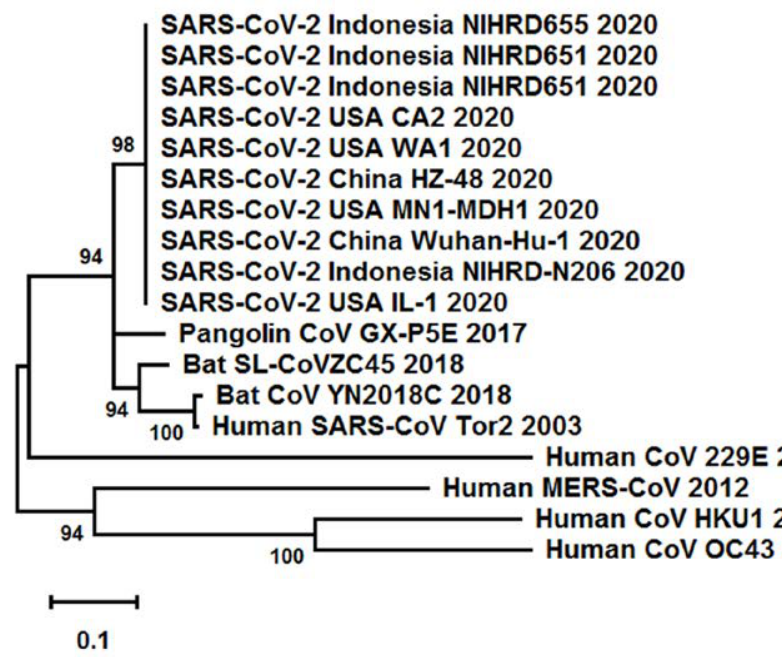
Fig. 4. Phylogenetic tree of SARS-CoV-2 and other CoV isolates based on the nucleocapsid protein